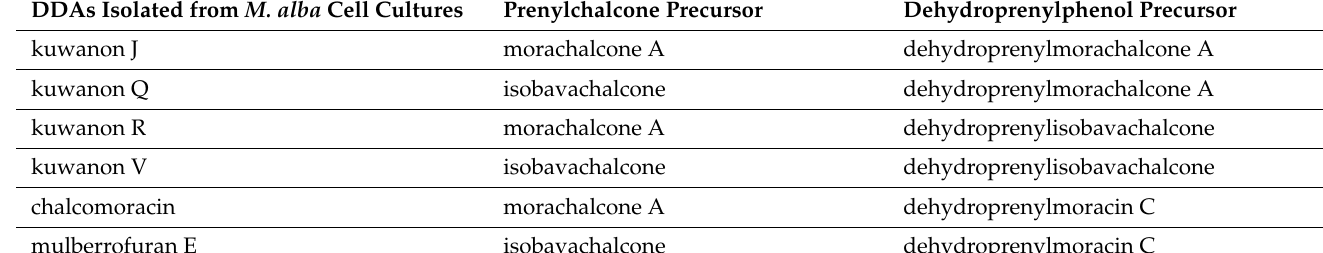
Table 1. DAAs isolated from M. alba cell cultures and corresponding putative precursors. DDAs Isolated from M. alba Cell Cultures